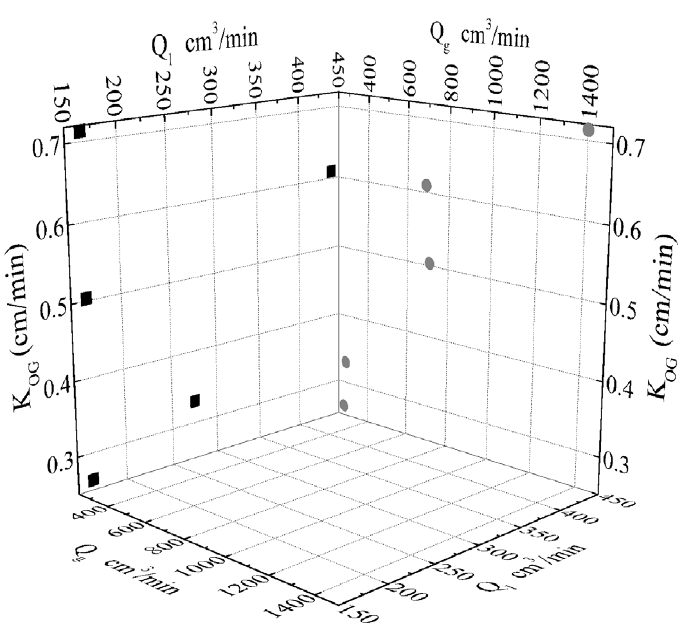
Figure 9. Calculated overall mass transfer coefficients (K OG ) as a projection onto the two planes of K OG -Q g and K OG -Q l . K OG -Q g and K OG -Q l